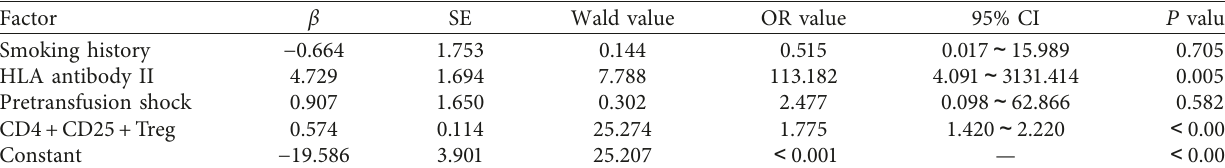
Table 3: Logistic regression